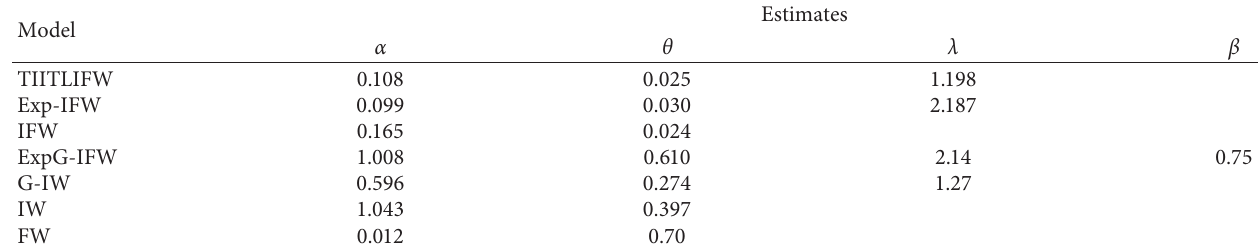
Table 4: The MLEs for lifetimes